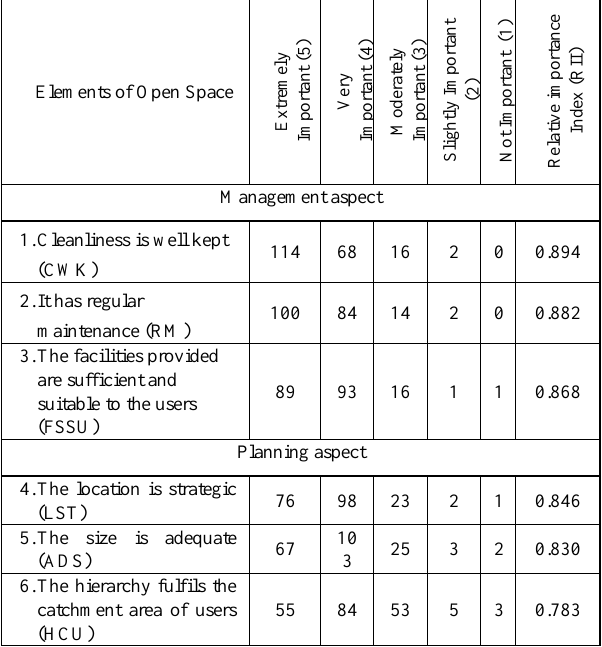
Table 1: The importance of elements of open space